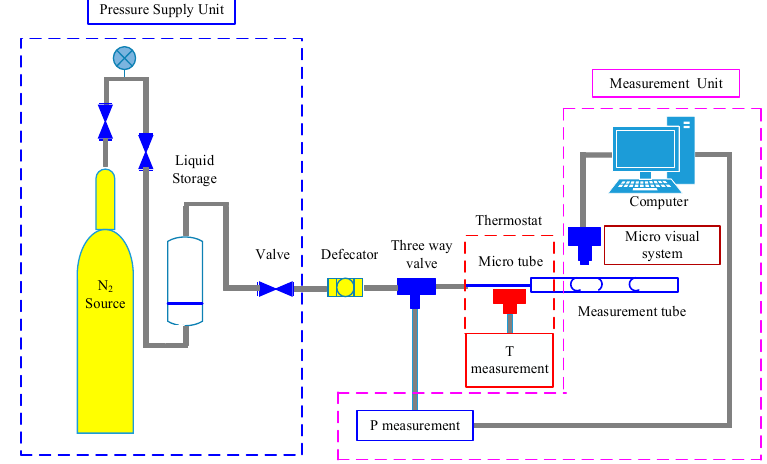
Figure 2. Schematic diagram of micro-tube experiment.